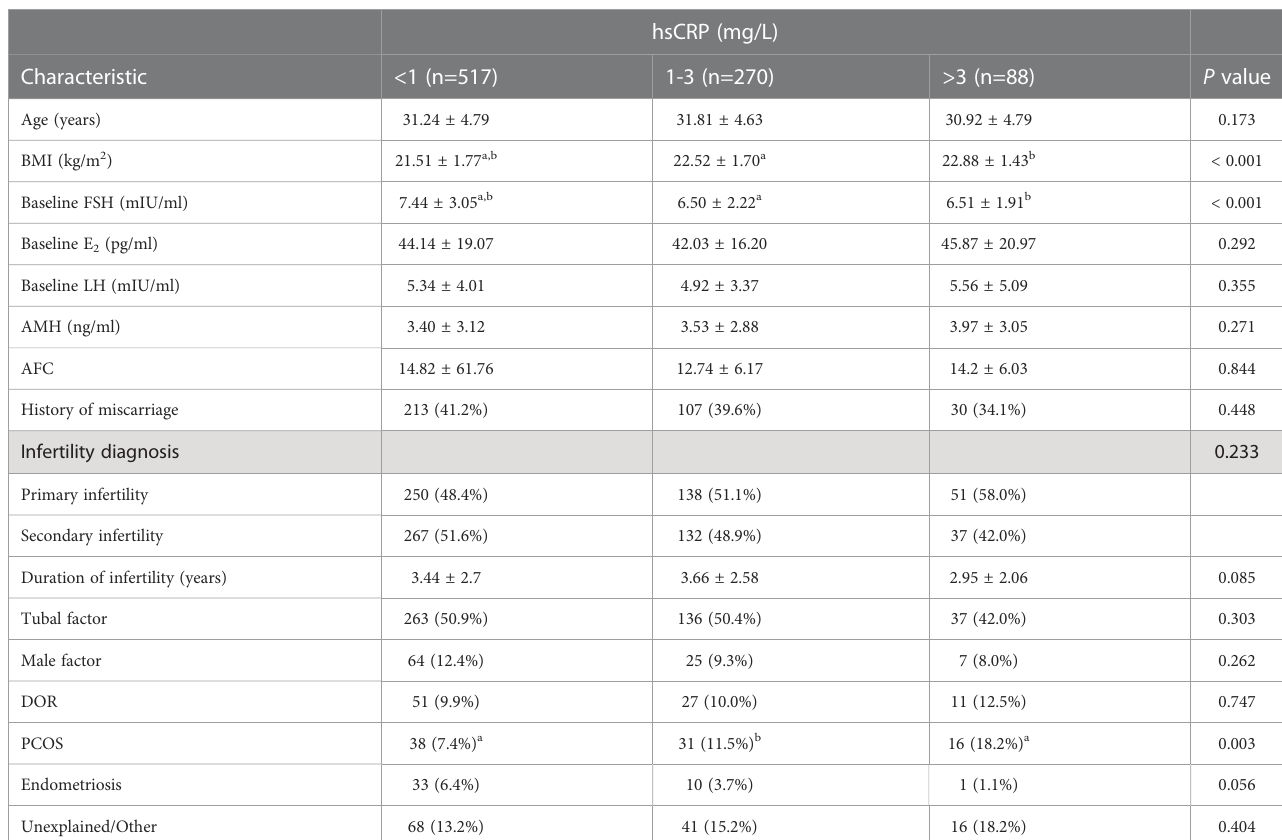
TABLE 1 Basic clinical characteristics of women with low, moderate and high